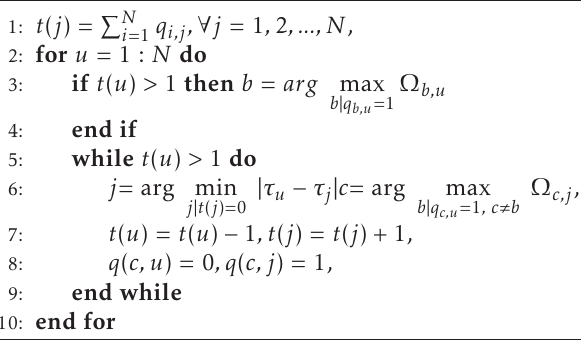
Algorithm 2 Greedy method to achieve q by satisfying constraint